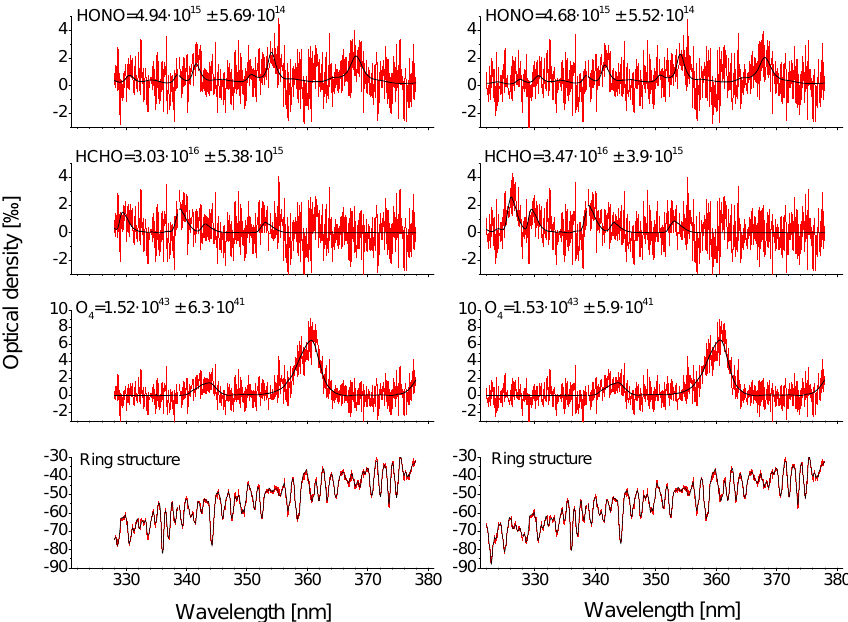
Figure 1. Example fits using two different wavelength ranges for spectrum C0004375 (18:27:04UTC inside the cloud) of the nadir spec- trometer. For each absorber the slant column density is given next to the name. As the fit coefficient of the ring spectrum is irrelevant for the rest of the paper it is omitted here. Left: the standard fitting window is used (328–378nm); right: an extended range beginning at 322nm is shown to include another HCHO absorption band. Within the error margins the results of both fits agree quite well.